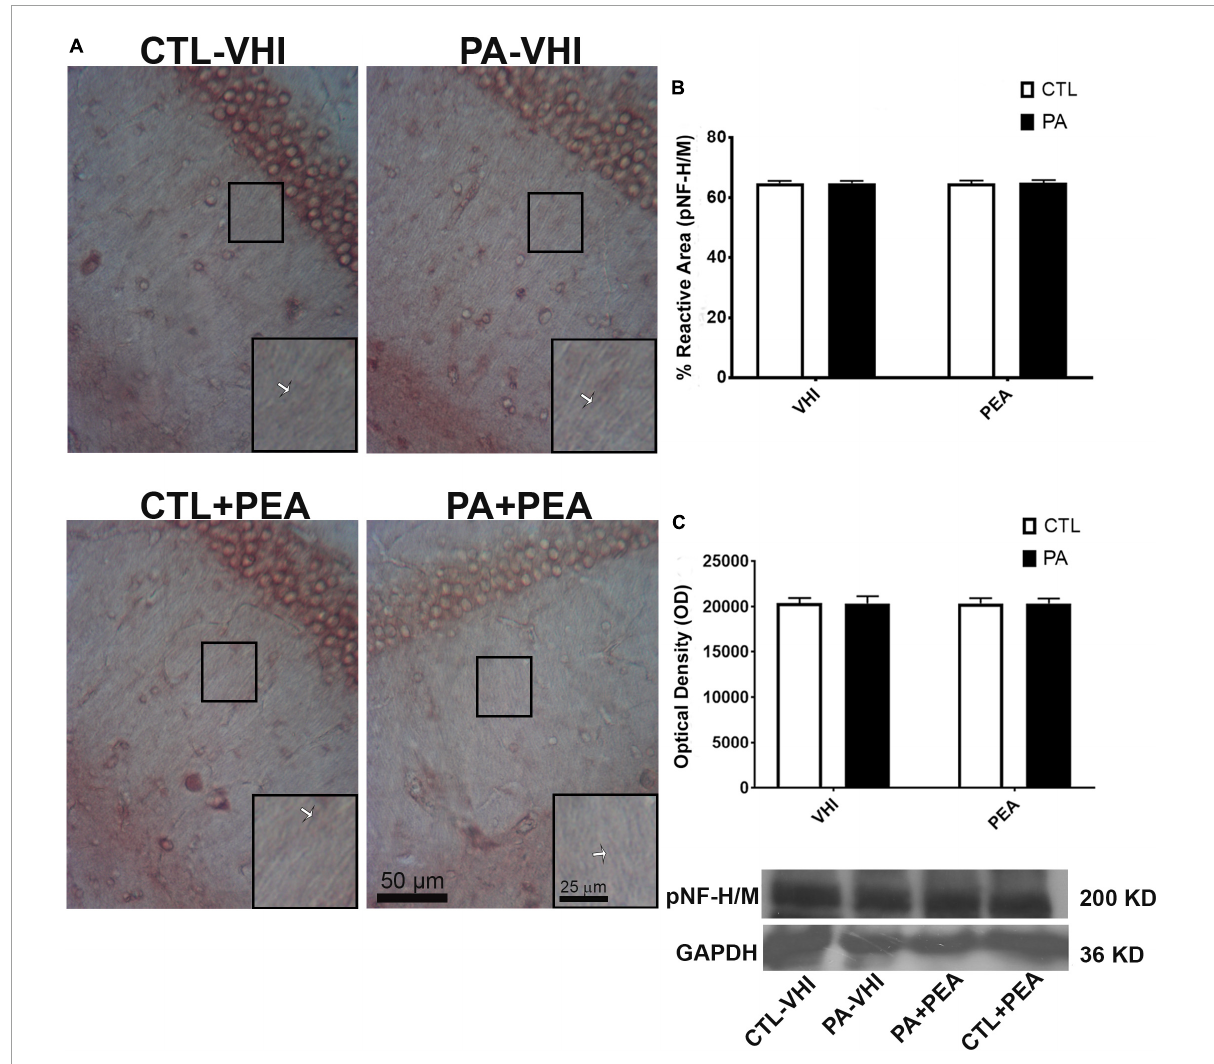
FIGURE8 Phosphorylated high and medium molecular weight neurofilaments (pNF H/M) immunostaining and protein expression in the rat hippocampus on P21. (A) Representative images of the stratum radiatum of CA1 hippocampal area immunostained for pNF H/M. Scale bar: 50 µ m. Marked rectangular areas in the main-image are shown magnified in the corresponding lower right margin. The white arrow indicates positive immunostaining for pNF H/M. Scale bar: 25 µ m. (B) Percentage of reactive area of pNF H/M positive axons. (C) Optical density of bands showing pNF H/M protein expression in Western blot. Results are shown as mean ± SEM. PA-VHI, rats subjected to PA and treated with vehicle; PA + PEA, rats subjected to PA and treated with PEA; CTL + PEA, control rats treated with